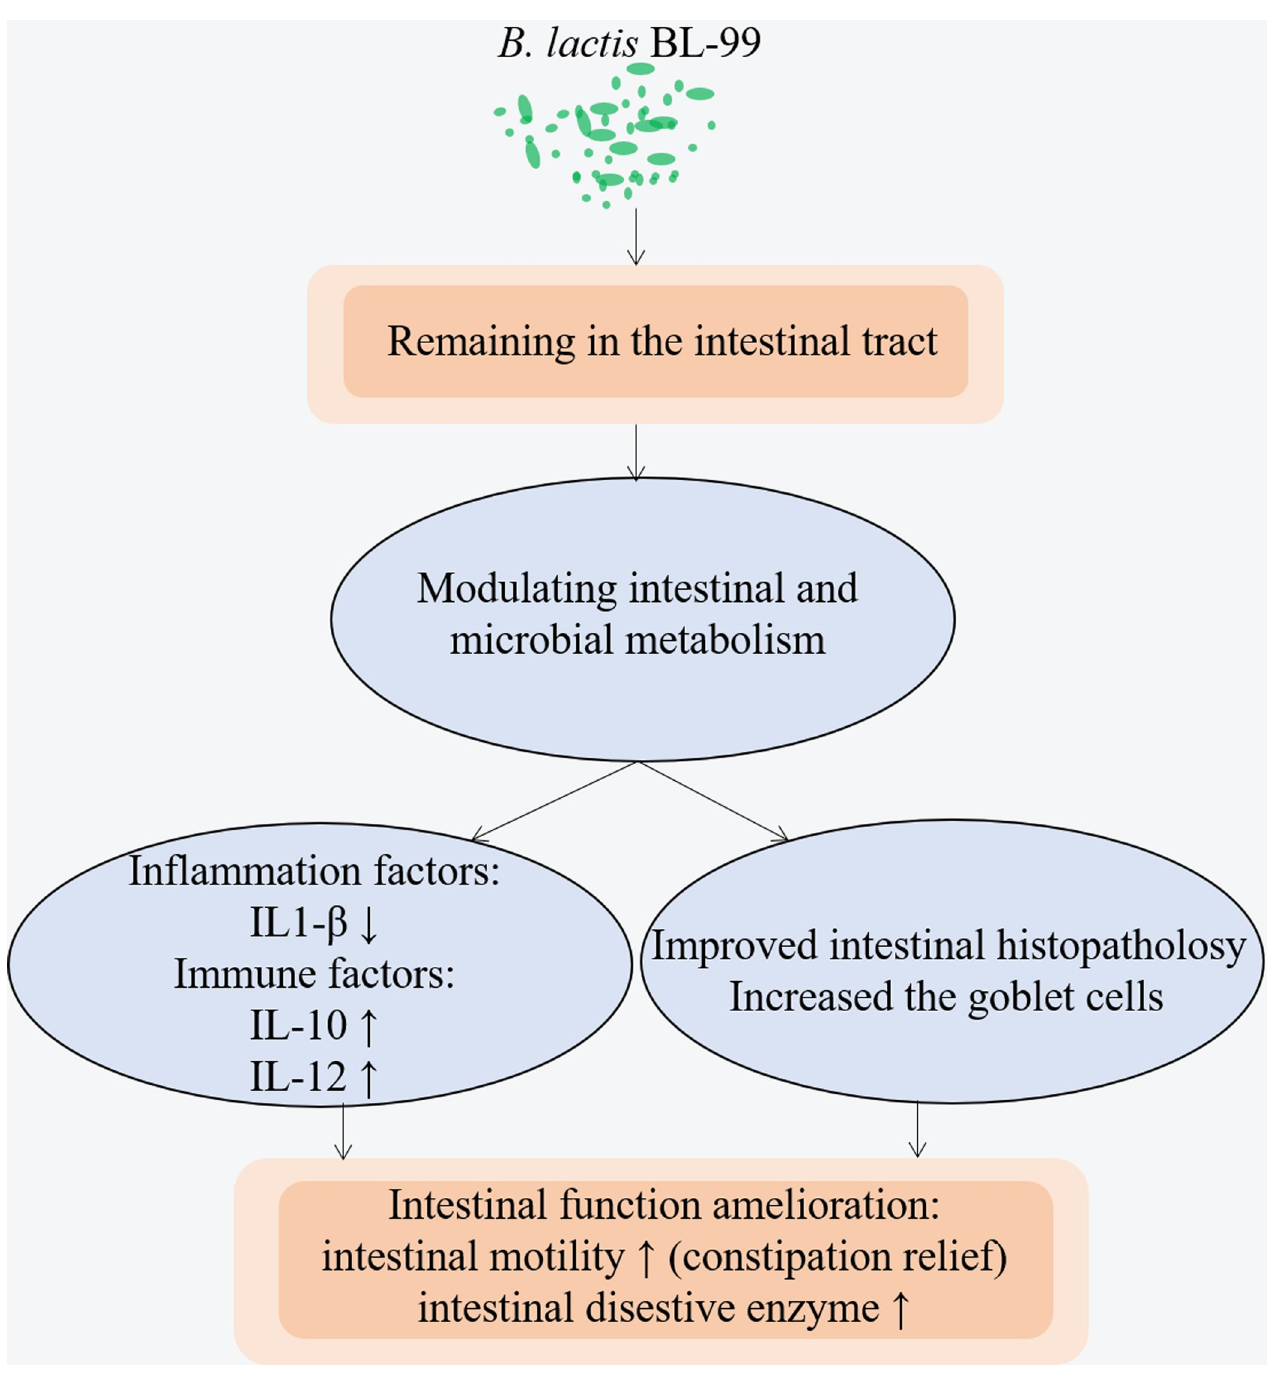
Fig 7. Possible mechanisms of B . lactis BL-99 modulated the intestinal inflammation and functions.